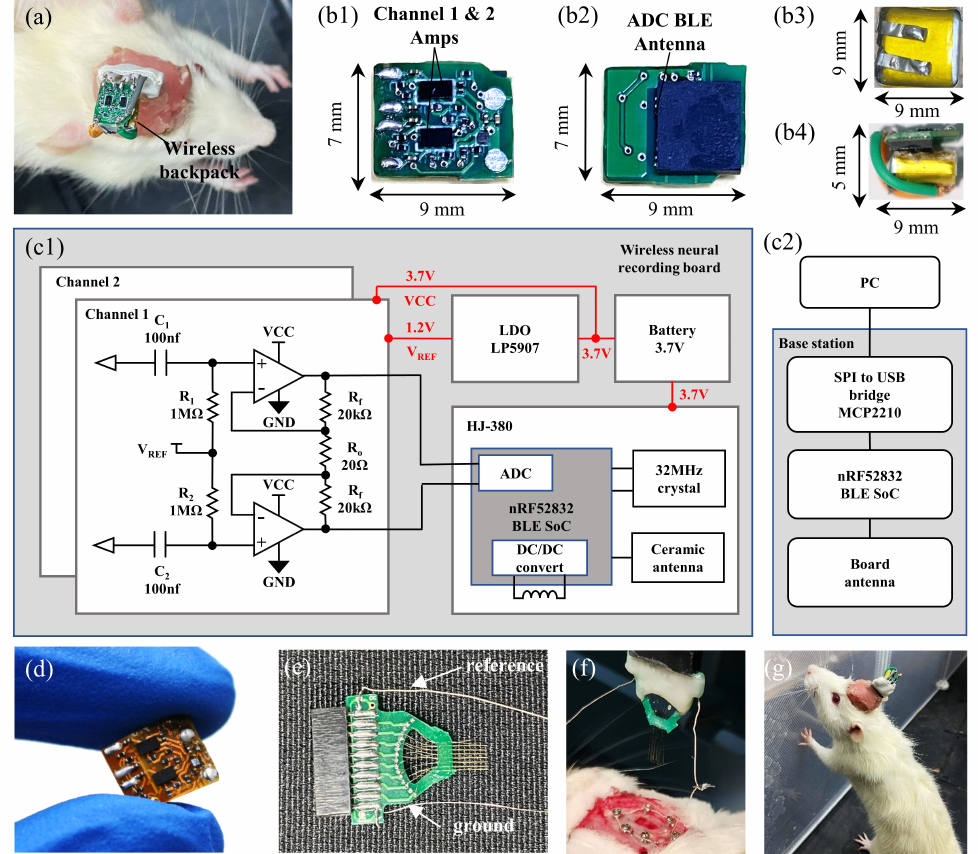
Figure 2. Ultra − low noise, miniaturized and lightweight dual − channel wireless neural recording microsystem, and the freely moving rats within this system. ( a ) Photograph of a rat assembly with the wireless neural recording microsystem through an implanted 16 − channel rigid electrode array. ( b ) Photograph of components of the wireless neural recording microsystem: ( b1 ) op − amps of